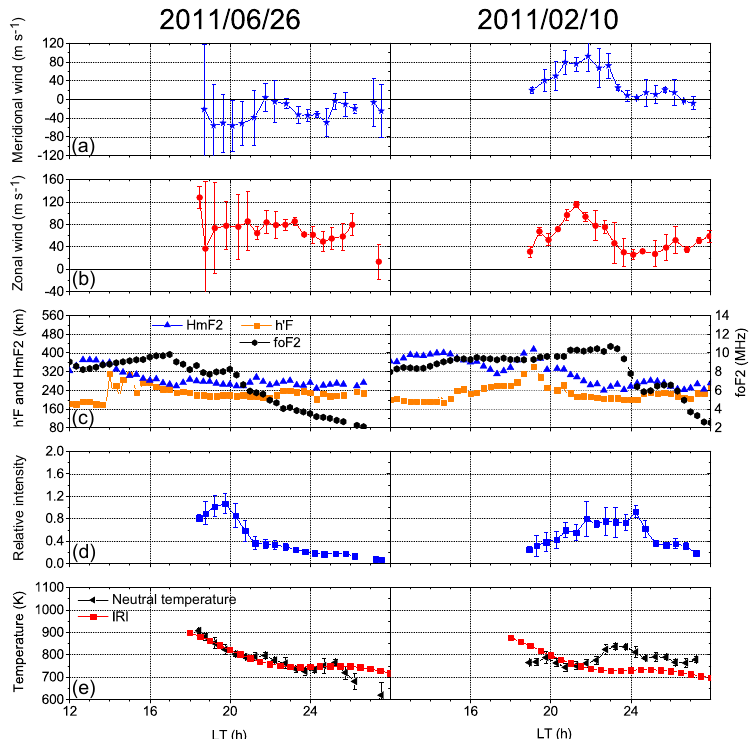
Figure 2. The meridional (a) and zonal (b) component of thermospheric neutral winds, fo F2 (c) , h (cid:48) F (c) , hm F2 (c) , relative intensity of OI6300 (d) ; the bottom panel (e) shows thermospheric neutral temperature with the averaged IRI-2012 curves, shifted to match the observed temperatures in the early evening. All these parameters were plotted for days without (26 June 2011) and with (10 February 2011) MTM. Positive values are northward and eastward. LT is UT −